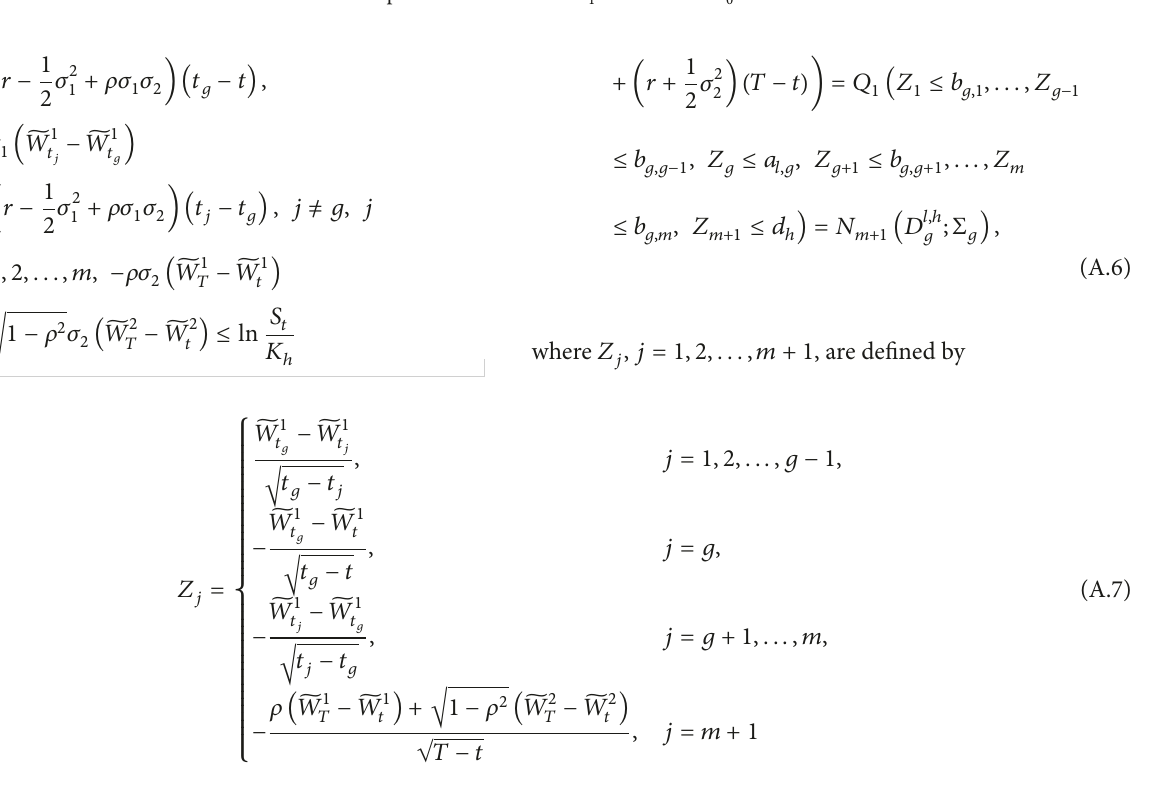
Figure 5: Option Δ and Γ at time 𝑡 1 for different 𝑌 0